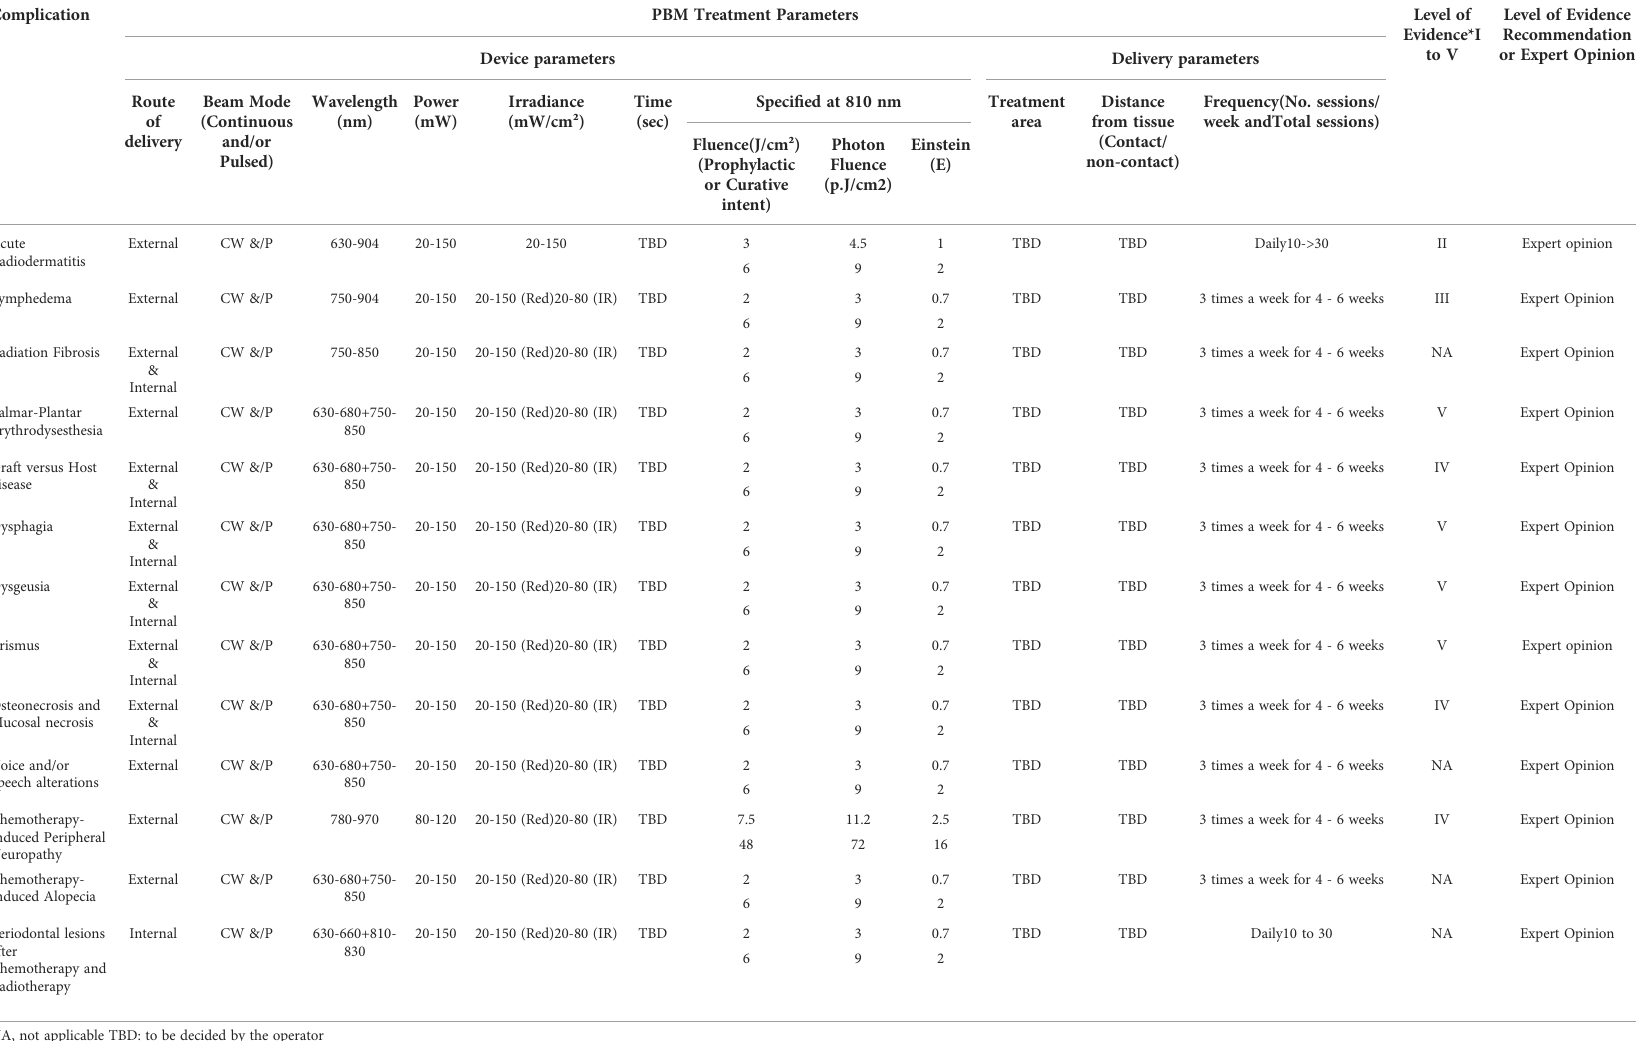
TABLE 3 WALT 2022 recommendations for PBM treatments in prevention and/or management of cancer therapy-related